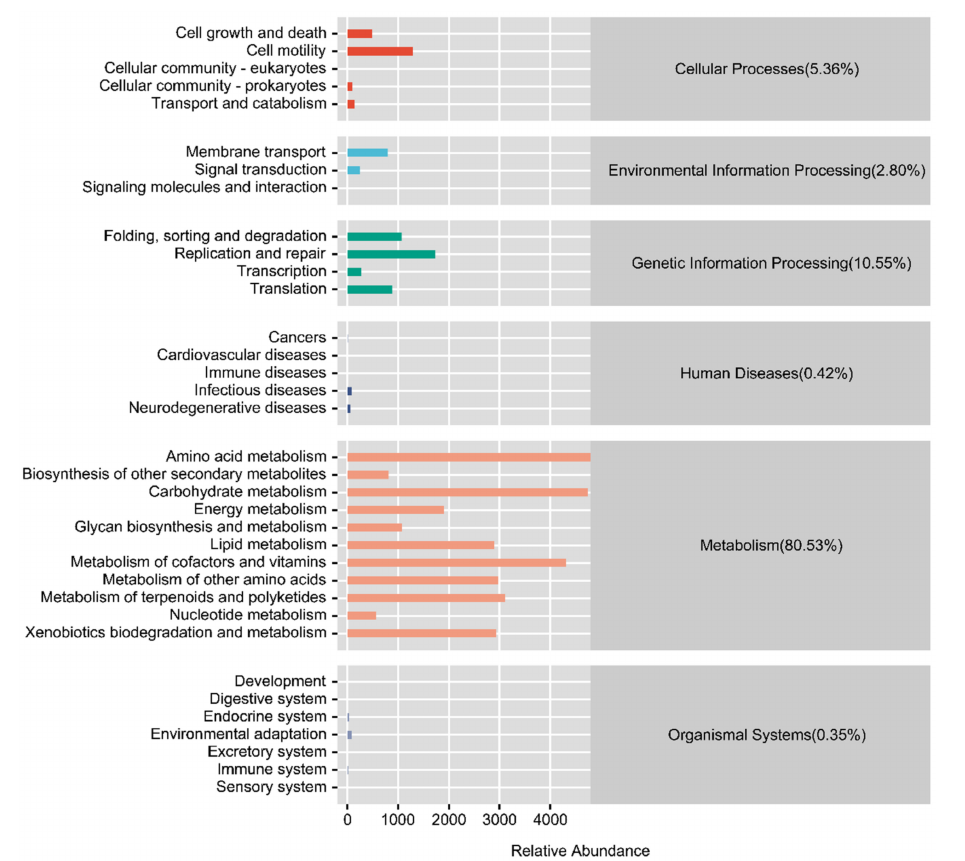
Figure 5. Functional annotation and relative abundance of Cipangopaludina cathayensis intestinal microbiota using Kyoto Encyclopedia of Gene and Genomes (KEGG) analysis at level 1 and level 2. The relative abundance of genes associated with a function is shown using colored bars (level 1). The detailed pathways are shown on the left (level 2).